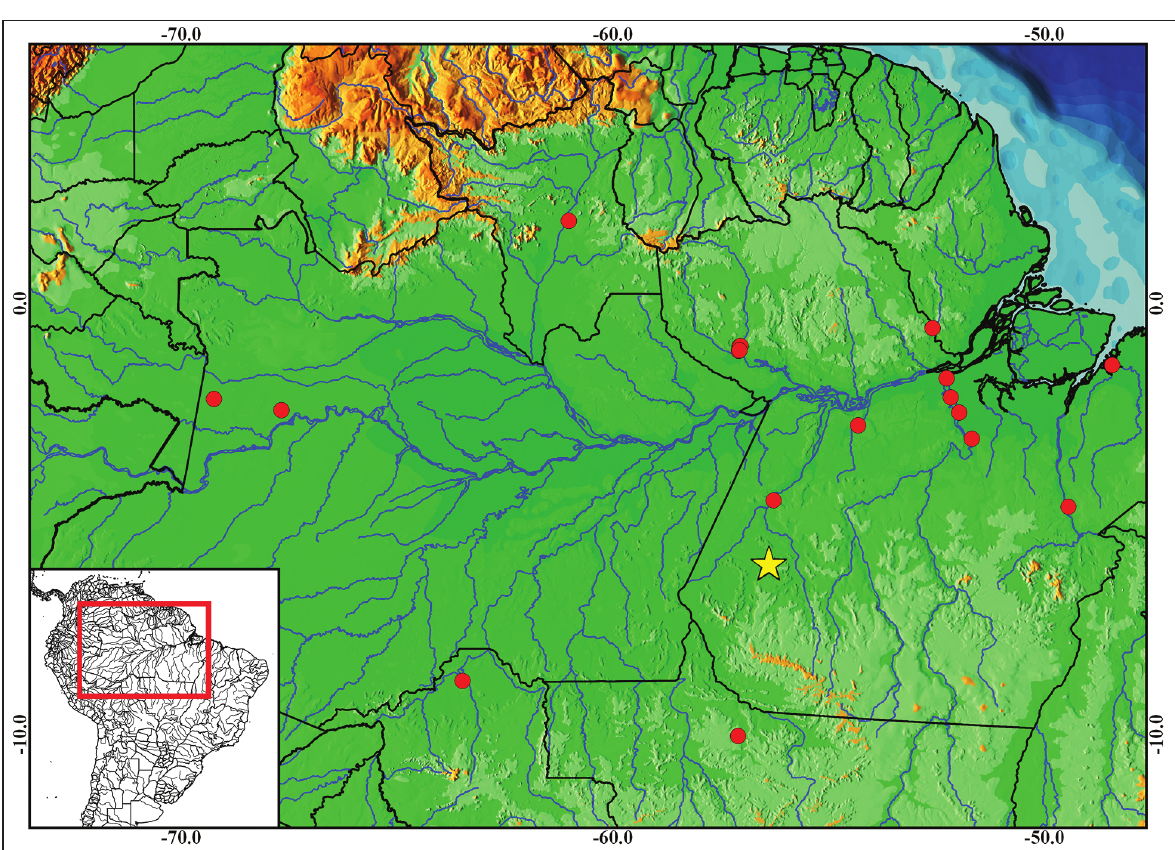
Figure 5. Distribution of Moenkhausia megalops . Circles represent lots examined; star indicates type locality in the rio Tapajós